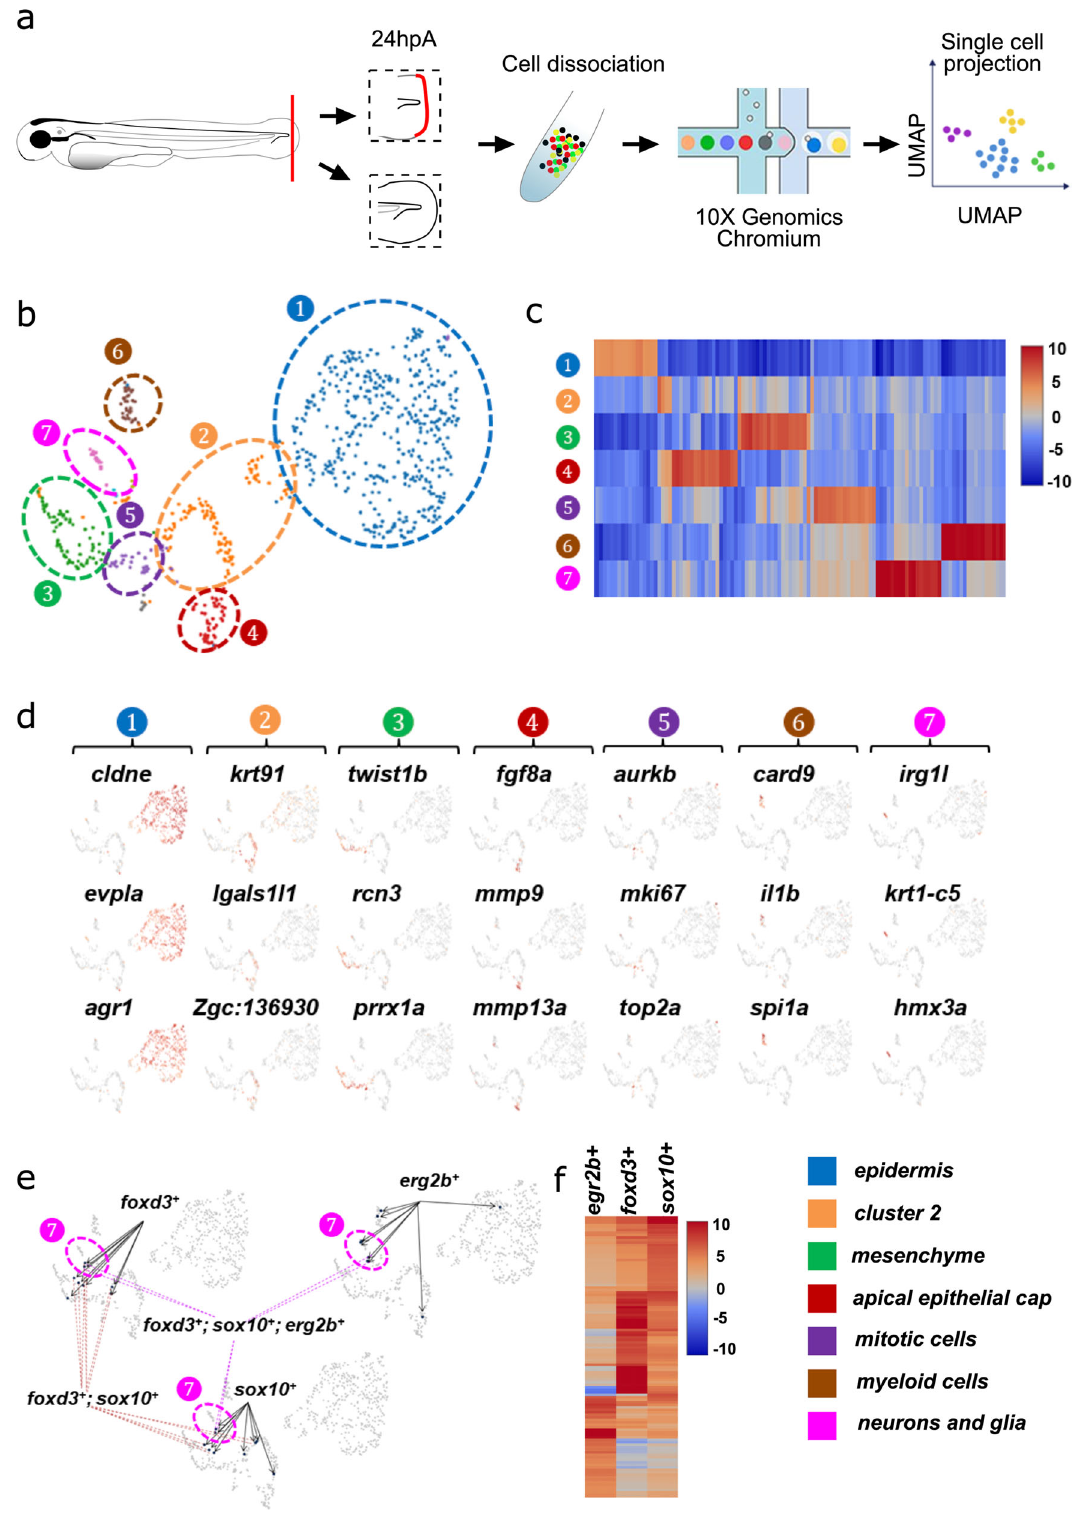
Fig. 1 Characterization of cells in the zebra fi sh blastema by scRNA-seq. a scRNA-seq experiment design. b Uniform Manifold Approximation and Projection (UMAP) plots visualizing RNA-sequencing data of single cells from the cut caudal fi n fold. Seven different cell clusters were identi fi ed c Heatmap displaying the genes that are differentially expressed in the seven clusters. Red, upregulated genes, and blue, downregulated genes. d UMAP representation of the expression (low to high, grey to red) of cell markers in the different clusters. e Foxd3 , sox10, and egr2b expression in cluster 7 (low to high expression, grey to blue). f Heatmap of the gene expression pro fi le of the foxd3 + , sox10 + , and egr2b + cell